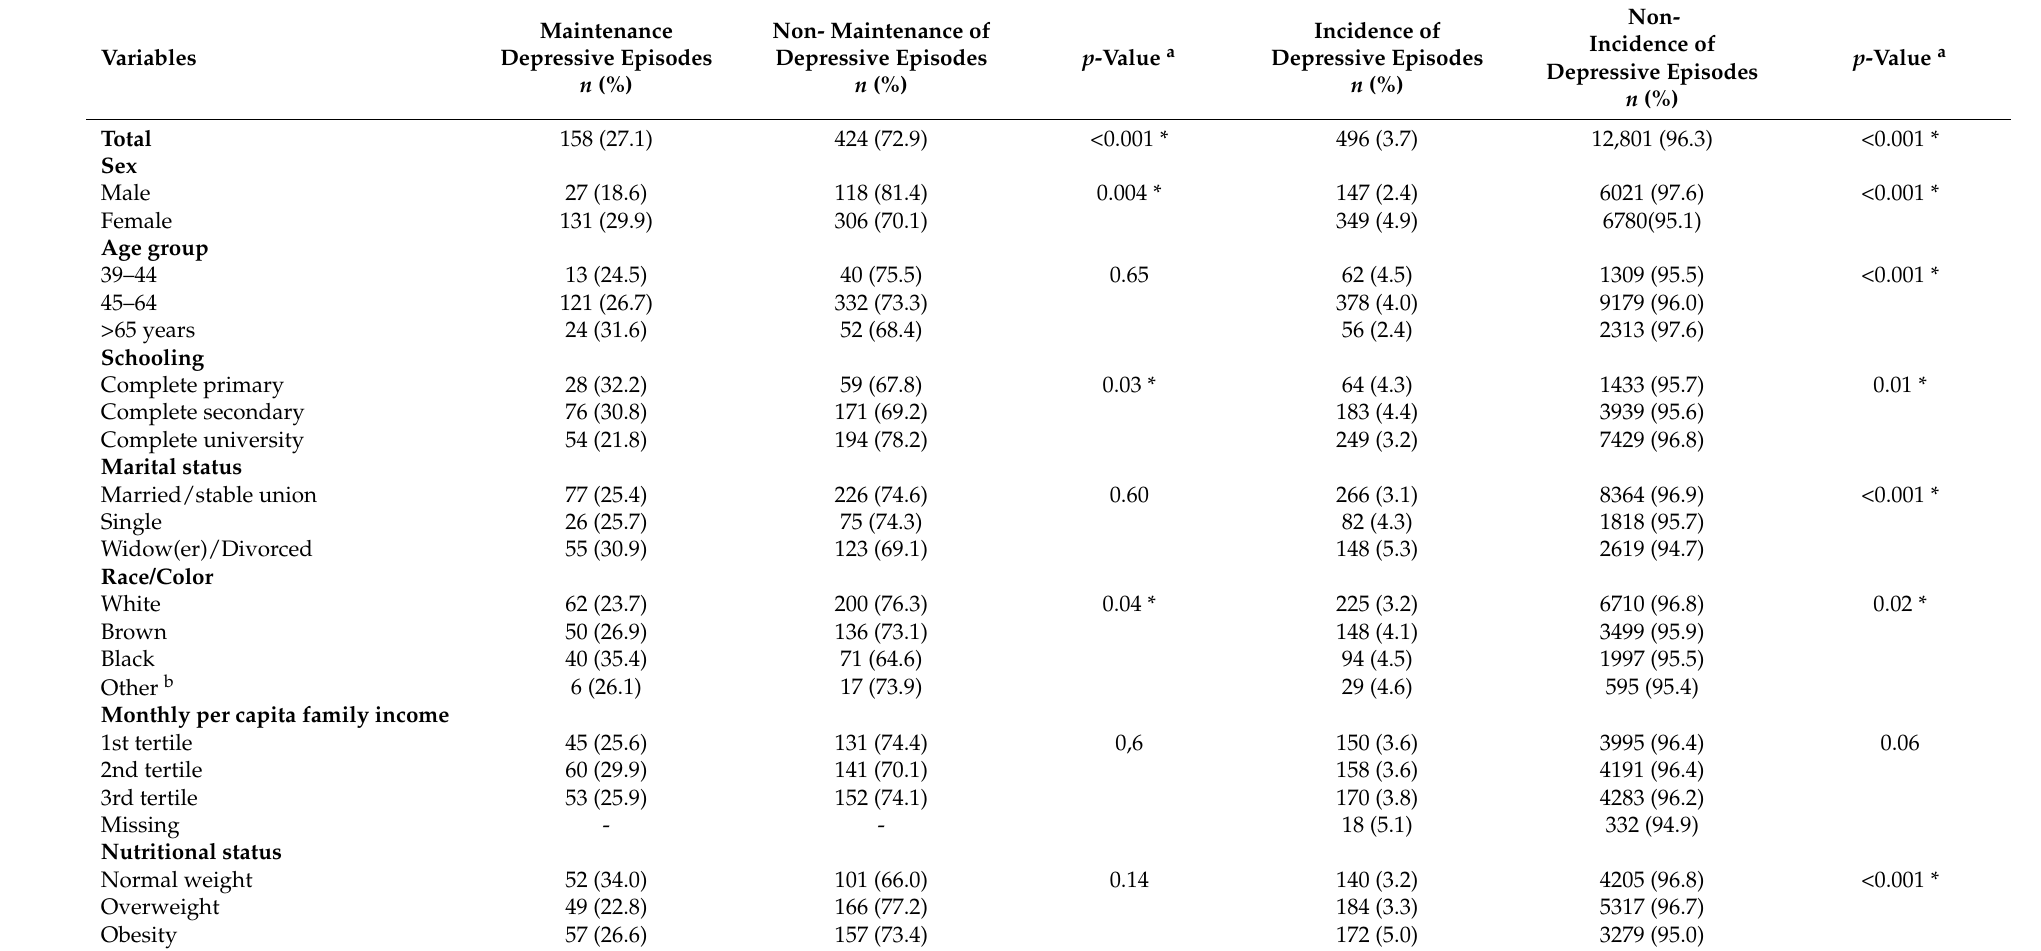
Table 1. Socioeconomic characteristics and health behaviors of participants in the ELSA-Brasil Study according to maintenance and incidence of depressive episodes, 2008–2010 (baseline) and 2012–2014 (first follow-up